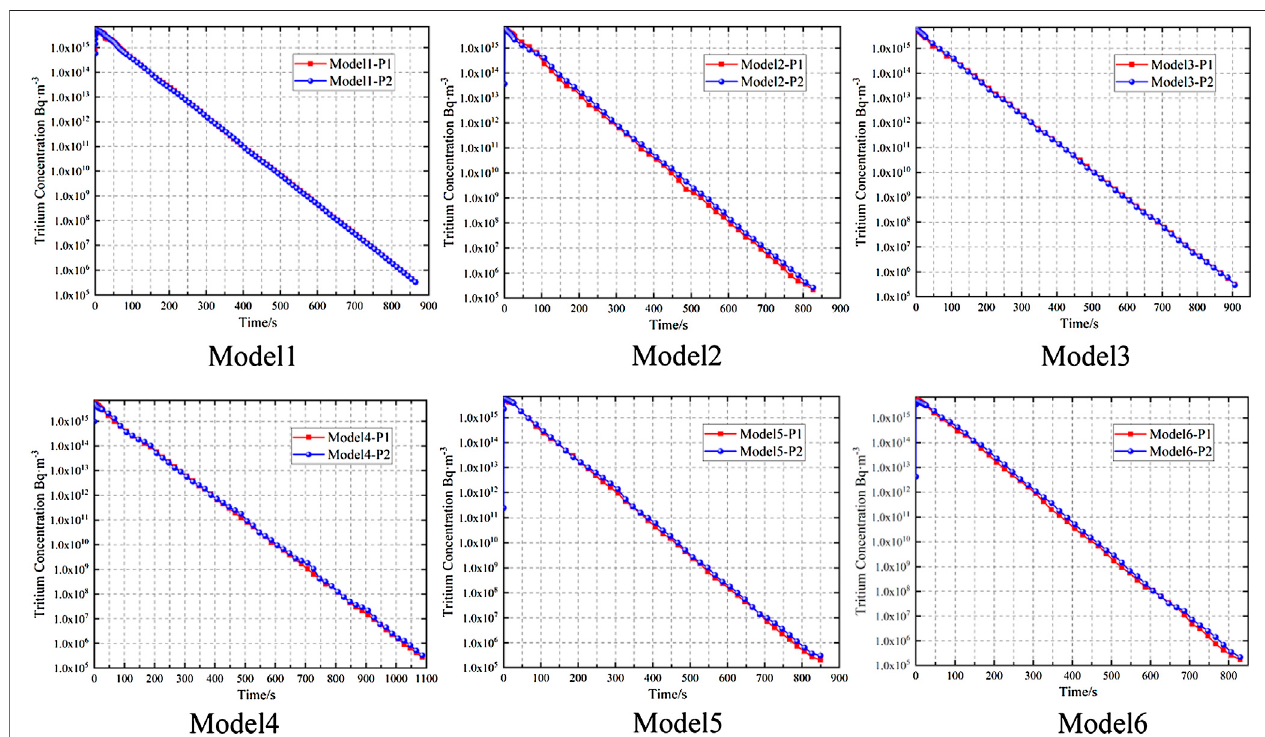
FIGURE 9 | Variation of tritium concentration at monitoring points in the